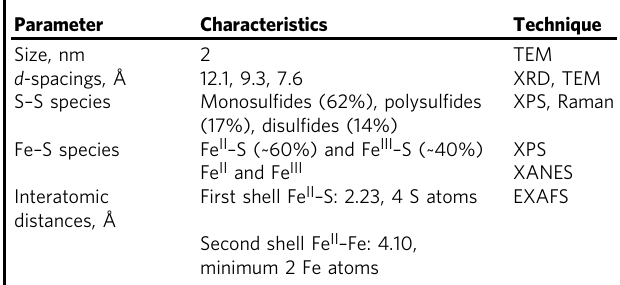
Table 1 Characteristics of the new phase FeS nano formed and stabilized at pH <